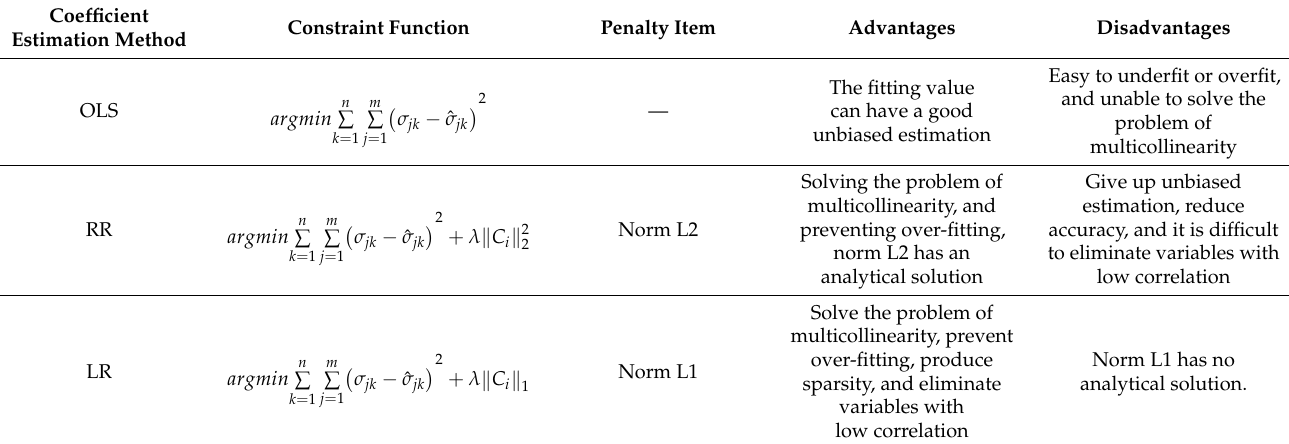
Table 1. Coefficient estimation method principle for multiple linear regression